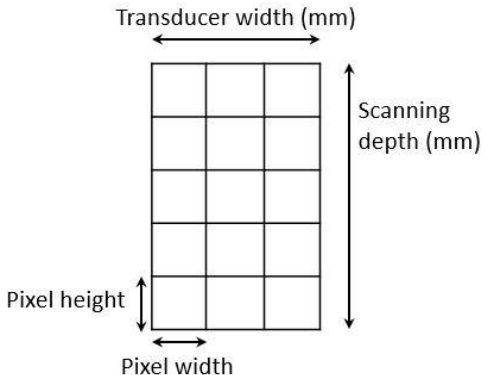
Figure 4. Diagram of an ultrasound image and the dimensions needed to calculate the correspondence between pixels and millimetres.